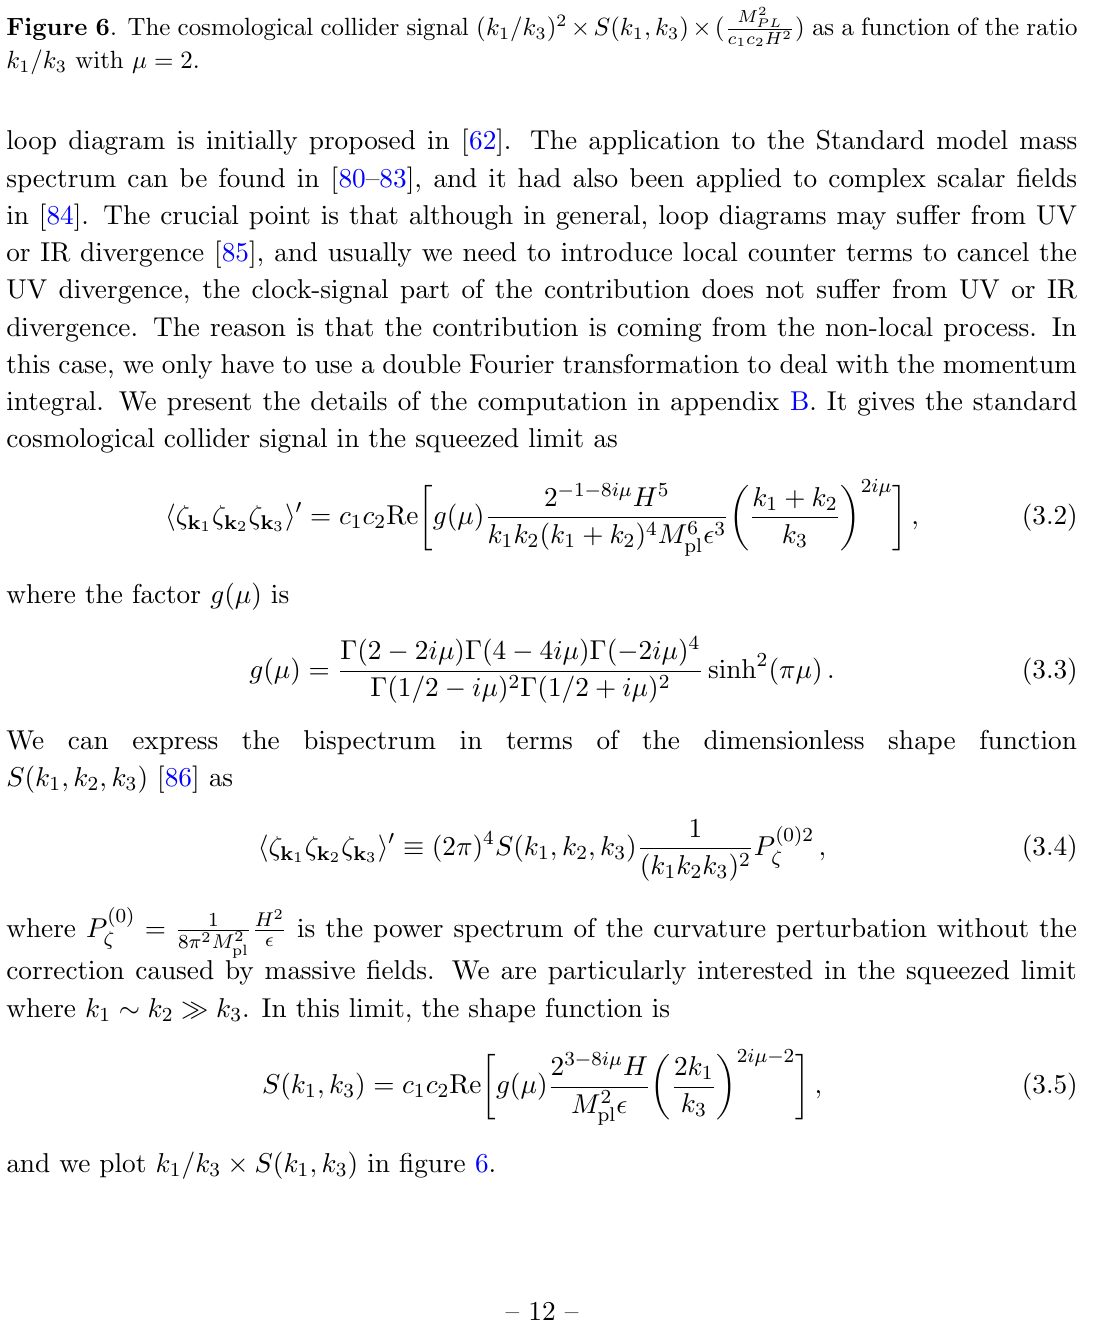
2 (cid:2) S ( k (cid:2) ( M 2 PL ) as a function of the ratio 1 =k 3 ) 1 ; k 3 ) c 1 c 2 H 2